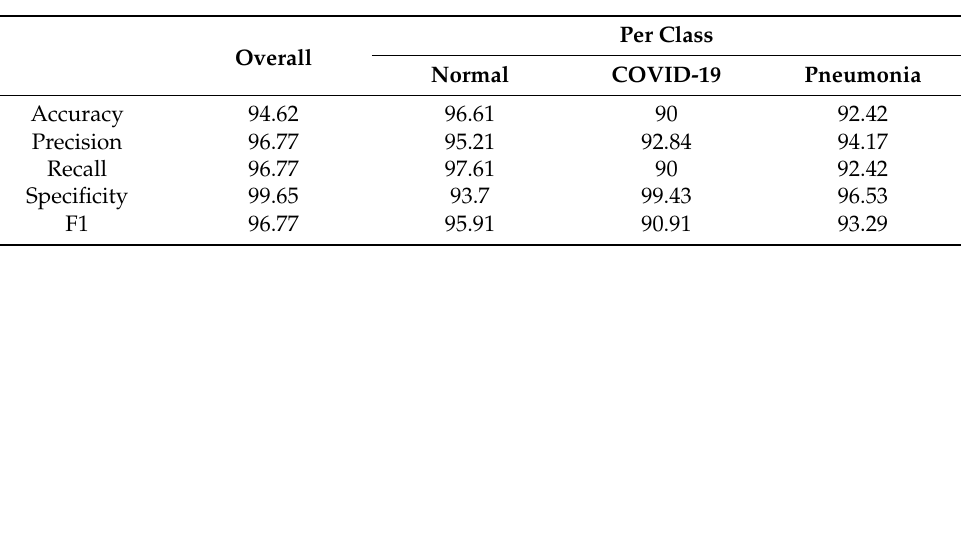
Table 2. Classification results (expressed as a percent) obtained on the COVIDX